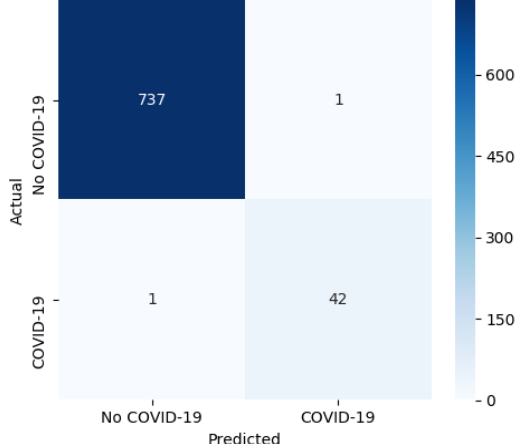
Figure 4. Confusion matrix of the binary